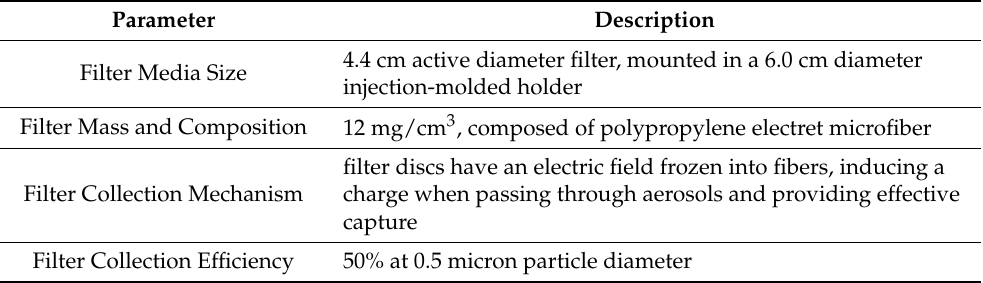
Figure 2. The scheme of the research stand used for examining the dispersion of the virus markers. Table 3. AirSampler filter